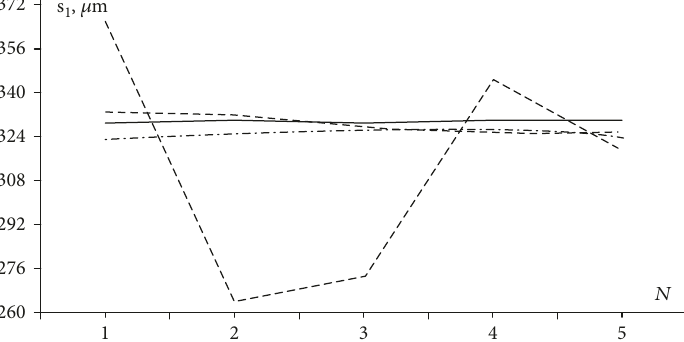
Figure 6: The results of GA optimization of s 30 ( – · – ); and 10 and 100 ( —